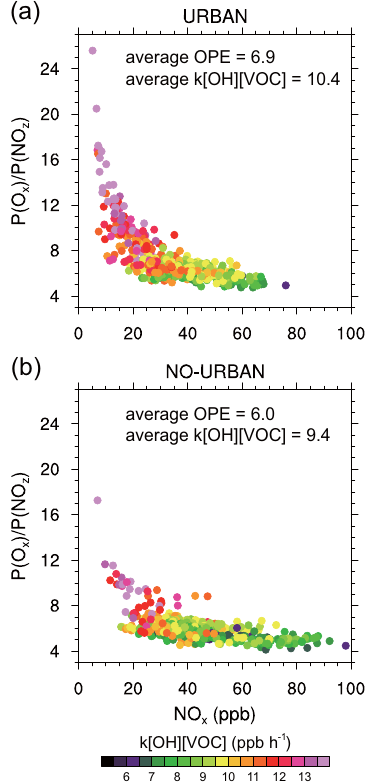
Fig. 12. Scatter diagrams of ozone production efficiency [OPE, cal- culated as P(O x ) /P(NO z ) ] and NO x concentration at 15:00 LT in the urban analysis area in the (a) URBAN and (b) NO-URBAN simu- lations. The color of circles indicates the rate of reactions between OH and VOCs (denoted by k [OH][VOC]). The unit of k [OH][VOC] is ppbh − 1